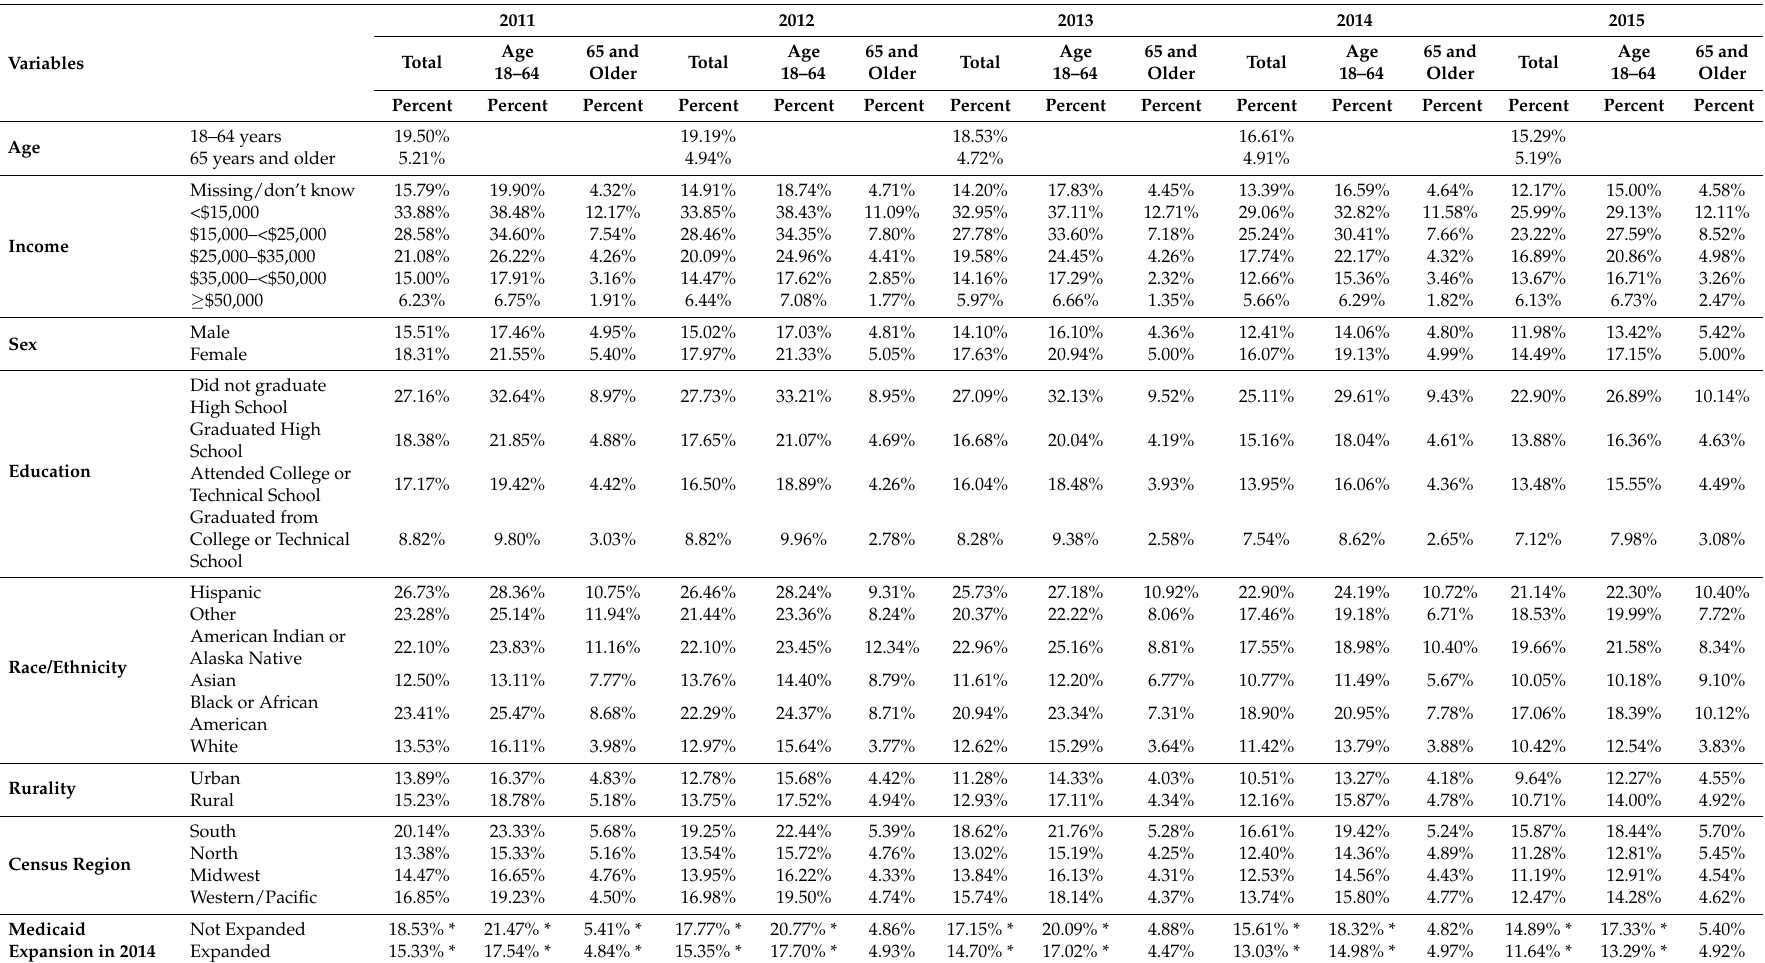
Table 1. Self-reported foregone care among adults,